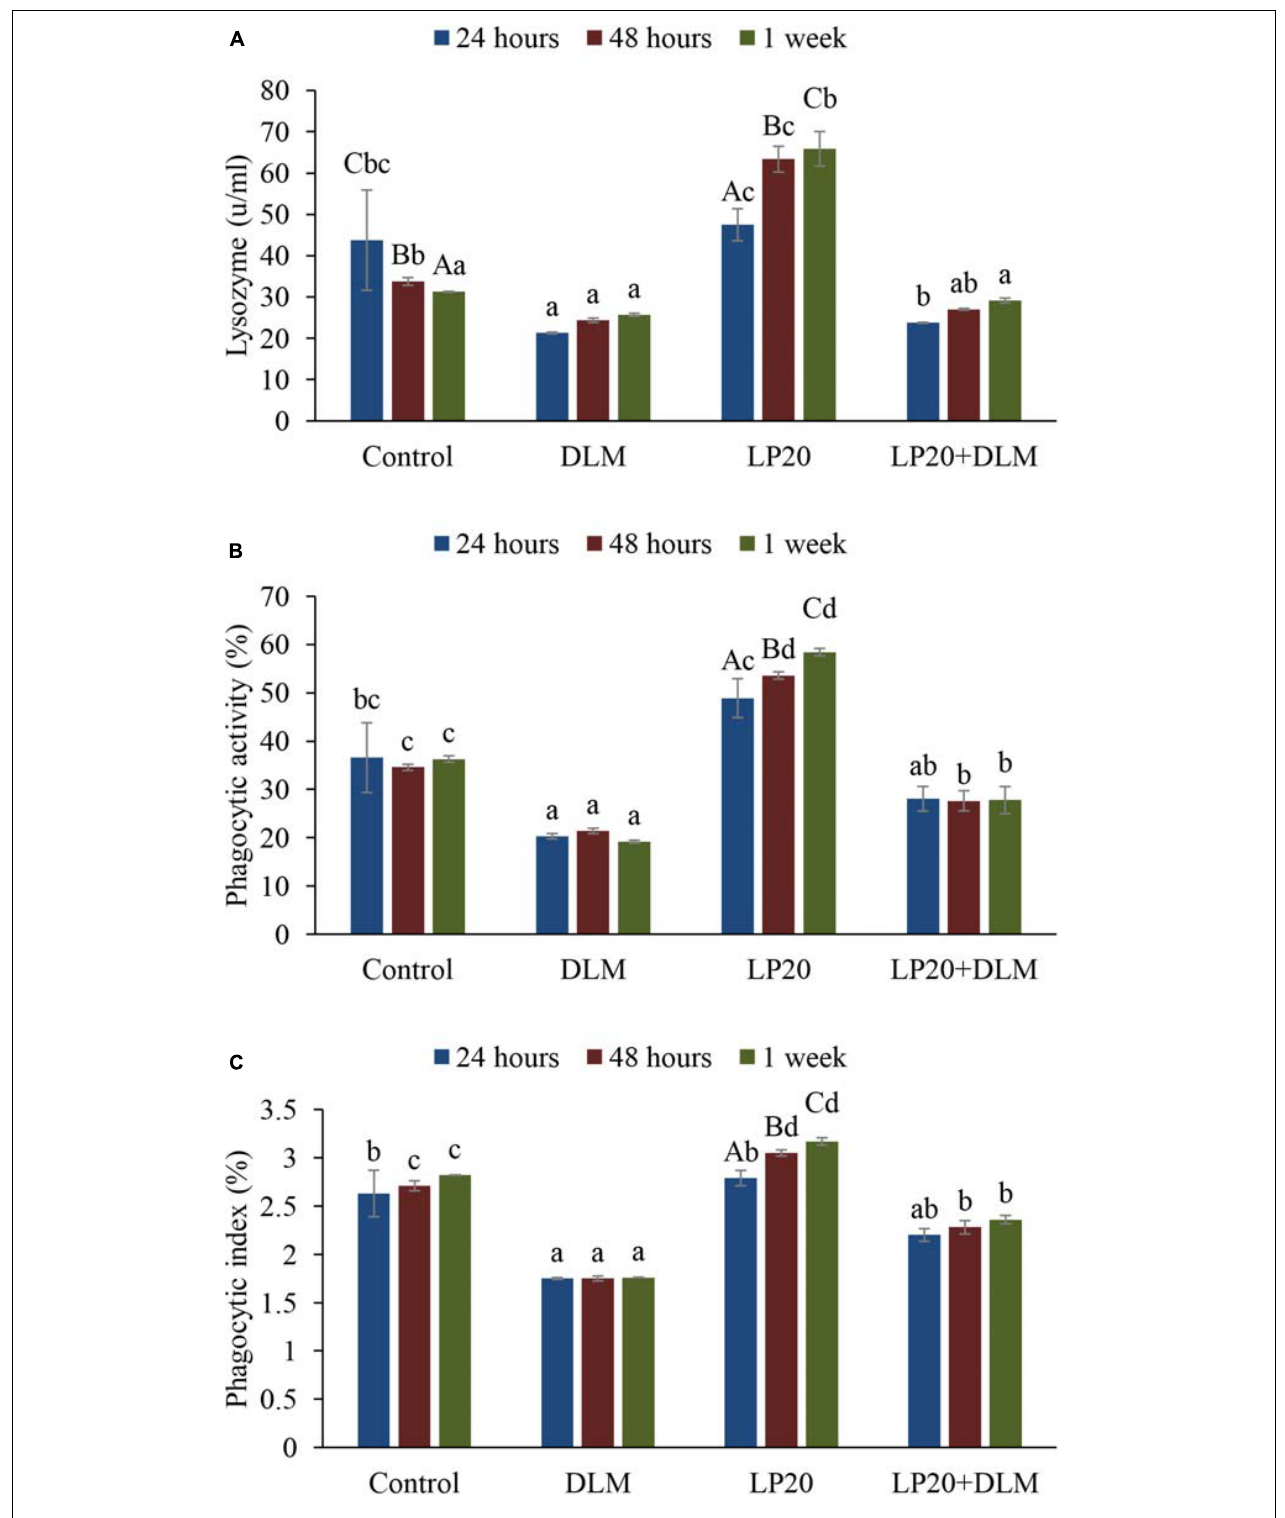
FIGURE 2 | Blood lysozyme activity (A) , phagocytic activity (B) , and phagocytic index (C) of Nile tilapia exposed to DLM and challenged with Aeromonas hydrophila and fed diets with or without LP20 for 30 days. Values are expressed as mean ± SE from triplicate groups (nine fish per group). Bars with capital superscript letters indicate significant differences between groups, while those with small letters refer to differences within the same group and among the different sampling periods for each parameter ( P < 0.05).